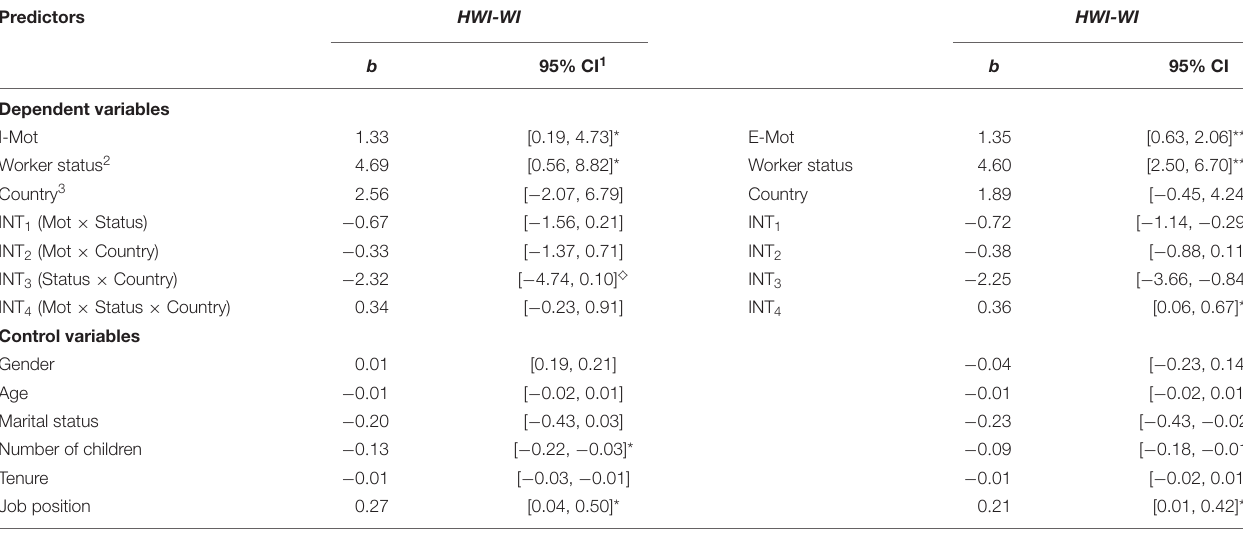
TABLE 5 | Moderated-moderation regression coefficients and confidence intervals (CIs) for predicting HWI-WI. Predictors HWI-WI HWI-WI 95% CI 1